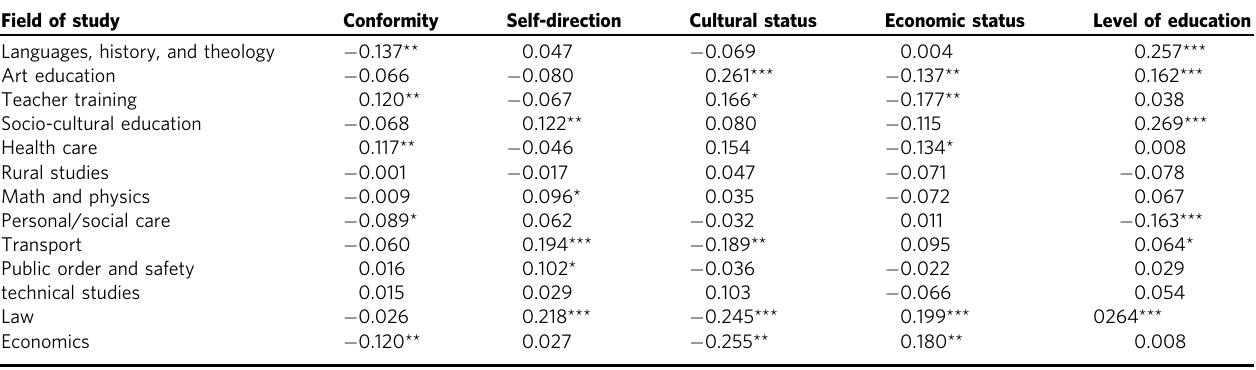
Table 4 Effects of parents ’ parenting style values, cultural and economic status, and current level of education on speci fi c fi elds of study for female adolescents.